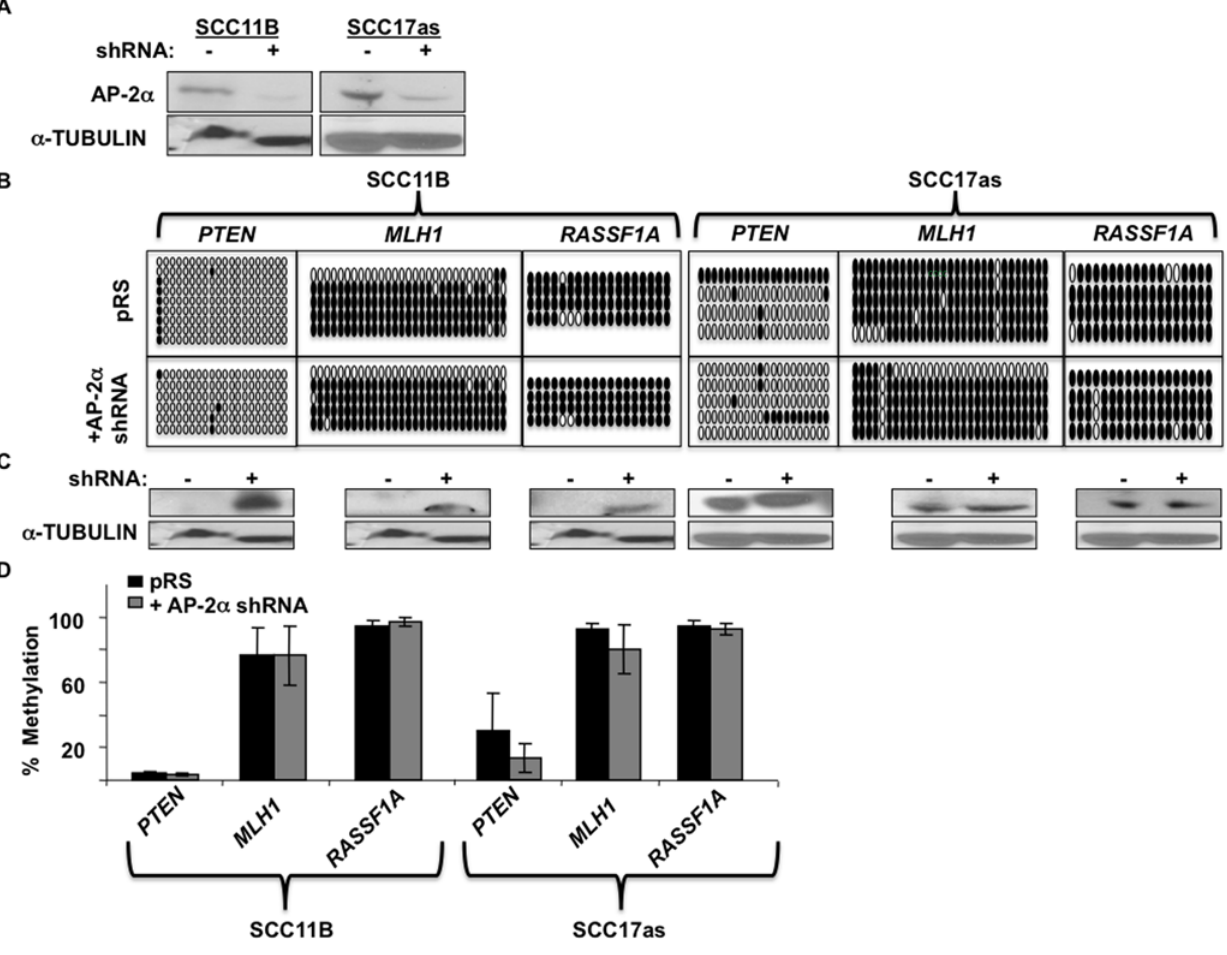
Figure 2. Varied target methylation and expression following AP-2 a downregulation in HNSCC cell lines SCC11B and SCC17as. a) Western blot analysis to confirm AP-2 a downregulation in SCC11B and SCC17as. b) Methylation in 3 target genes was compared between SCC11B and SCC17as cells with and without AP-2 a expression. Solid circles represent methylated CpGs; whereas, open circles represent unmethylated CpG sites. c) Western blot analysis was performed to analyze methylation’s affect on target expression. d) Graphical representation of the average methylation percentage in the 3 target genes analyzed.